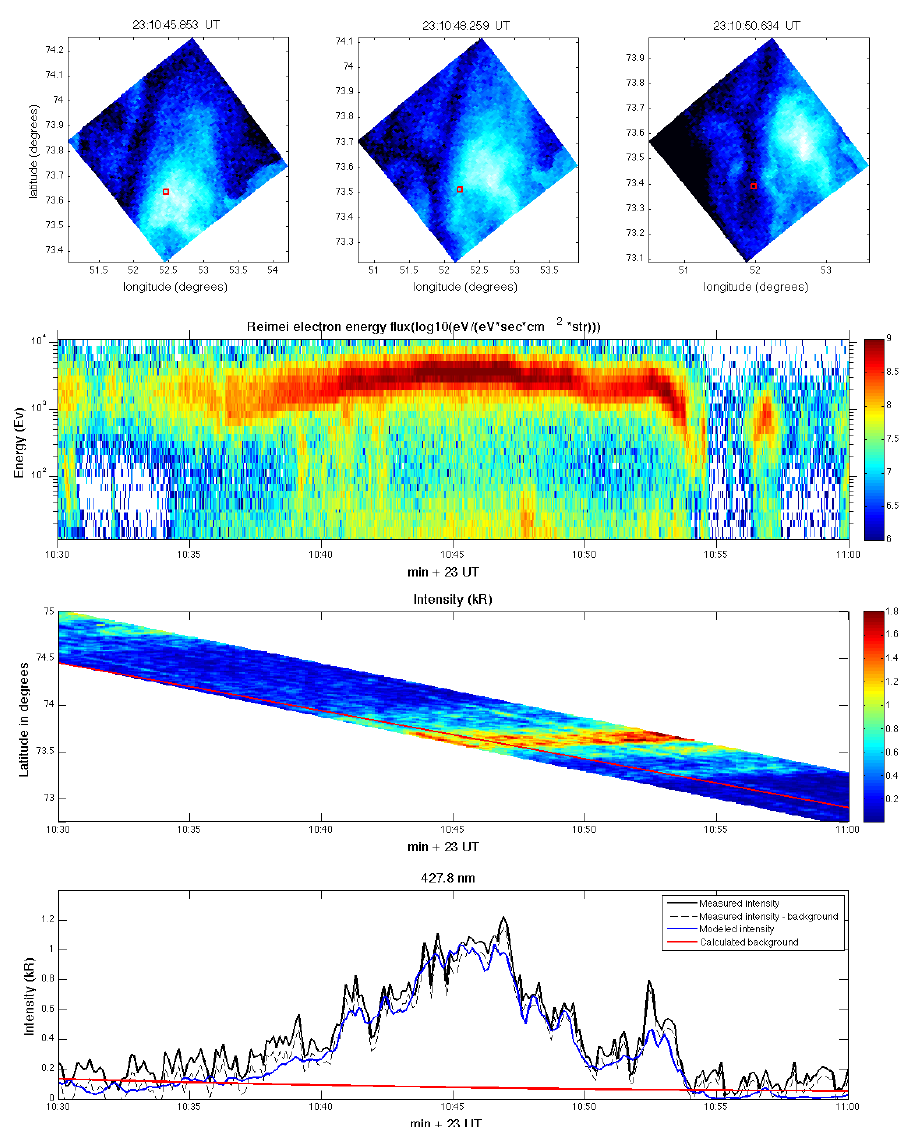
Figure 7. First panel: Images from MAC at three different times representing the event. The red square marks the satellite footprint. Second panel: Electron energy spectrum along the track of the satellite. Third panel: Keogram taken along the satellite track marked as the red line. Fourth panel: Measured and modeled intensity of the 427.8nm emission together with the calculated background intensity.